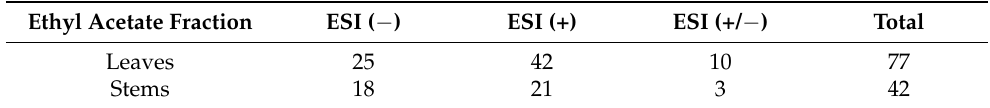
Table 1. Number of annotated metabolites (via MS and MS/MS) in each extract according to the ESI ( − ) and ESI (+) ionization modes.